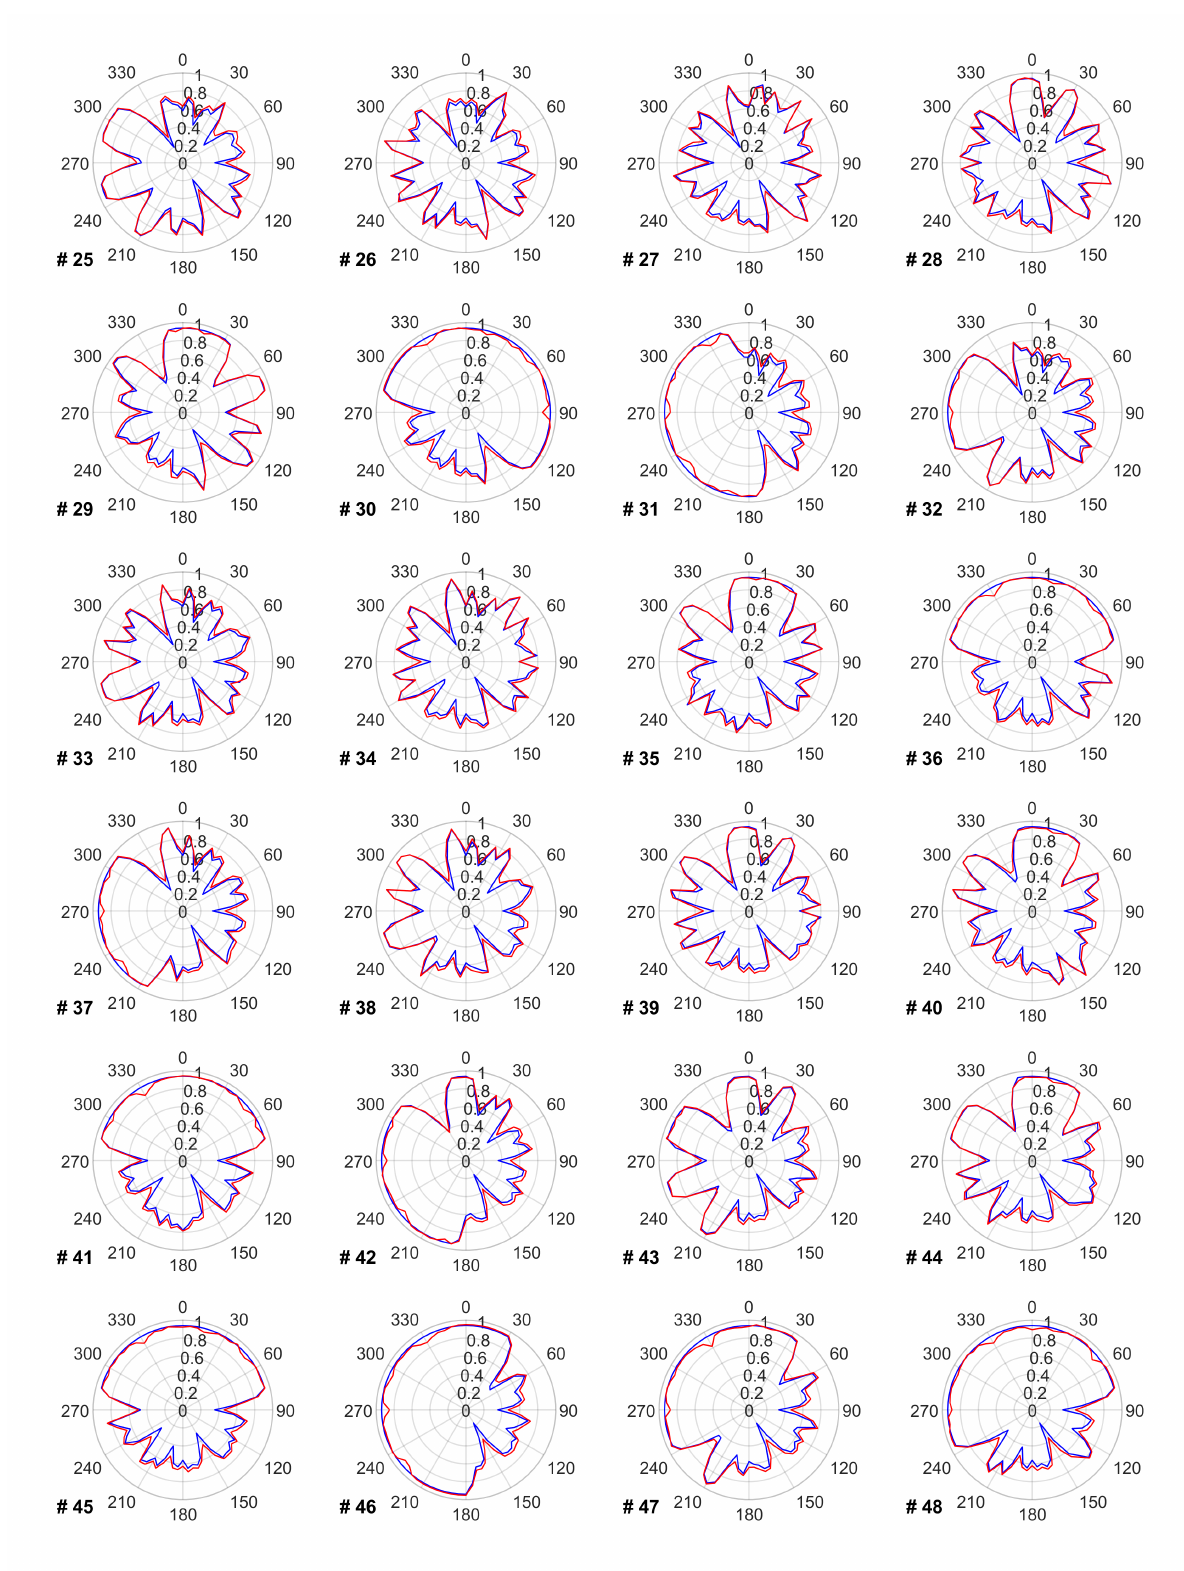
Figure A1. Blue line shows each turbine’s relative power production in every wind direction with- out applying a TSR optimization. Red line shows the relative power production after applying a TSR